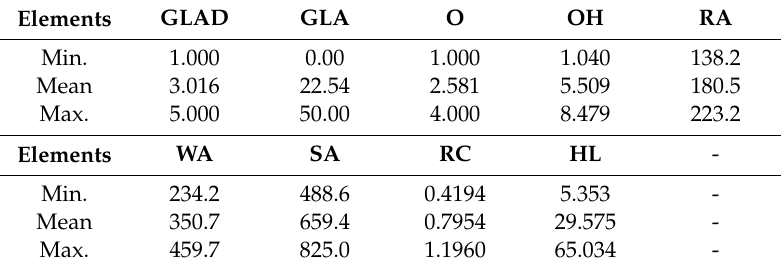
Figure 1. Illustrating the components of building [11]. Table 1. Summary of the heating load of the energy efficiency database used.